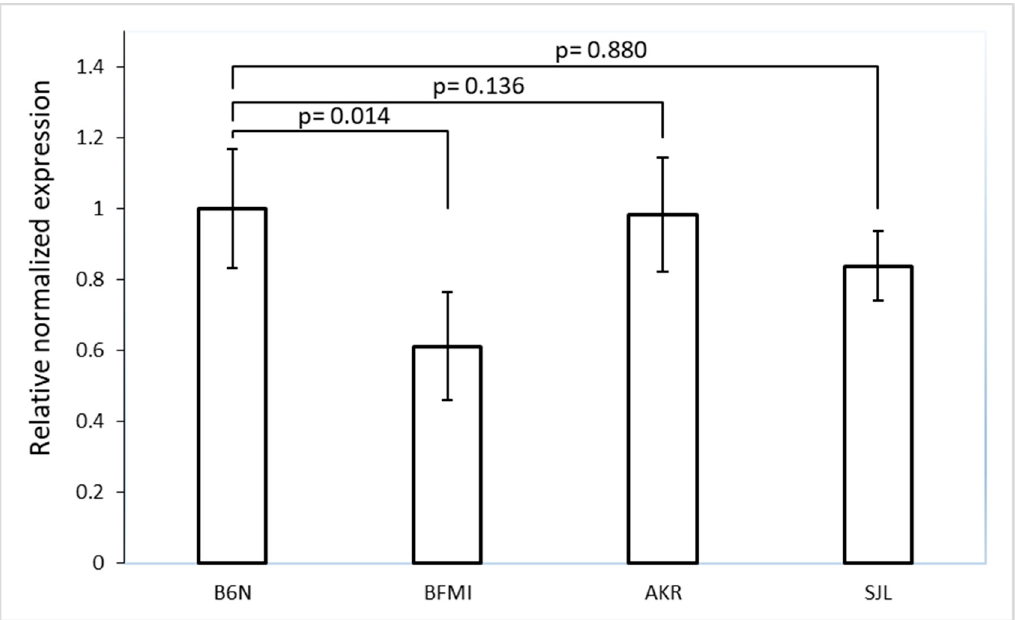
Figure 2. Normalized Bbs7 expression (RT-PCR) in the brain of 6-week-old BFMI, B6N, AKR, and SJL males. Beta-actin was used as the housekeeper gene. The expression of Bbs7 was decreased by almost 40% in BFMI versus B6N mice only (FC (BFMI/B6N) = 0.61). No significant difference was observed when comparing AKR and SJL with B6N .